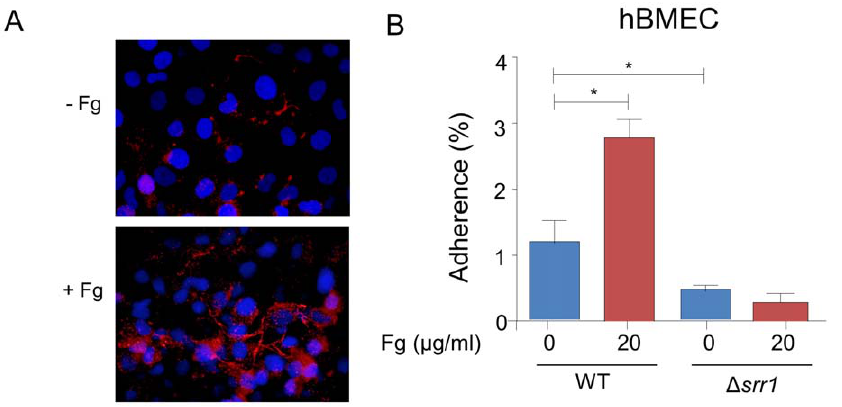
Figure 4. GBS adherence to hBMEC is mediated by the interaction of Srr1 and fibrinogen. (A) Fibrinogen on the surface of hBMEC pretreated with or without exogenous fibrinogen (Fg; 20 m g/ml). Nuclei were stained with DAPI (blue) and fibrinogen was detected with anti- fibrinogen IgG, followed by Alexa Fluor 488 conjugated anti-rabbit IgG (red). (B) NCTC 10/84 (WT) or PS2645 ( D srr1 ) incubated with hBMEC, with or without fibrinogen pretreatment (20 m g/ml). Unbound bacteria were washed out and bound bacteria were counted. Values represent percent (mean 6 S.D.) of total GBS inoculum bound to the monolayers. *=P , 0.01.